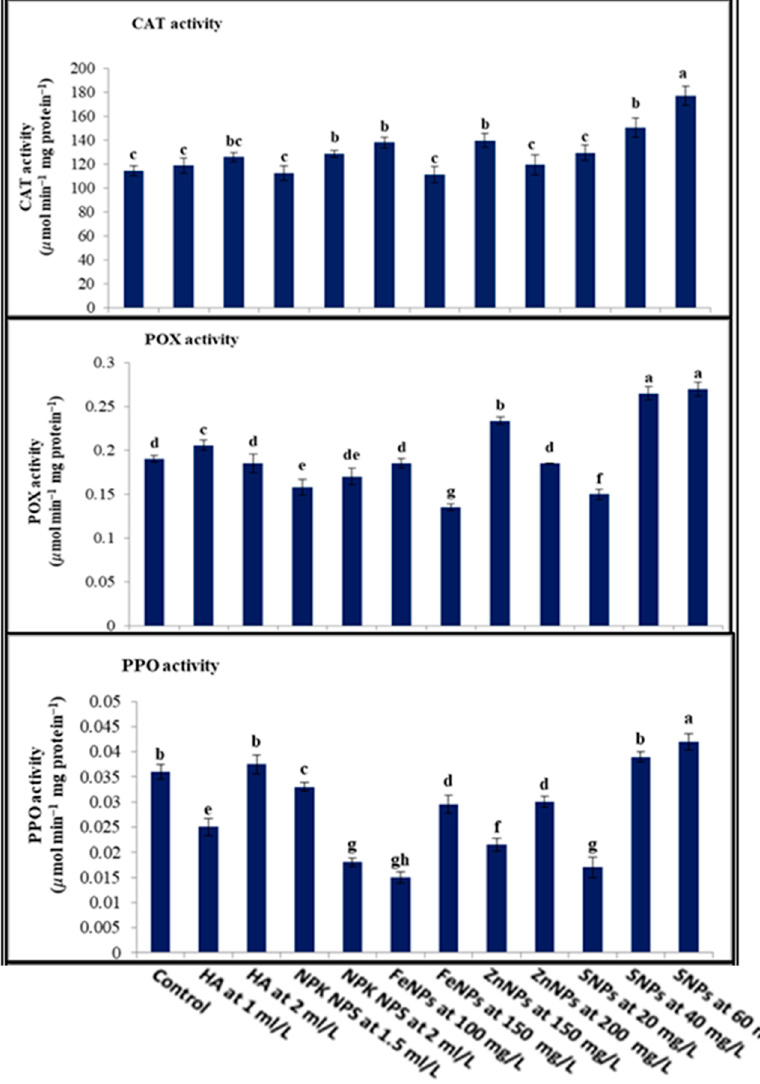
Figure 4. Effect of nanoparticles and humic acid on catalase, peroxidase, and polyphenol oxidase activities in Philodendron bipinnatifidum leaves in the second season. The same letters show no significant differences between the treatments according to ANOVA, Duncan’s multiple range test at 0.05 level. Data are the mean (±SE) of three replicates.